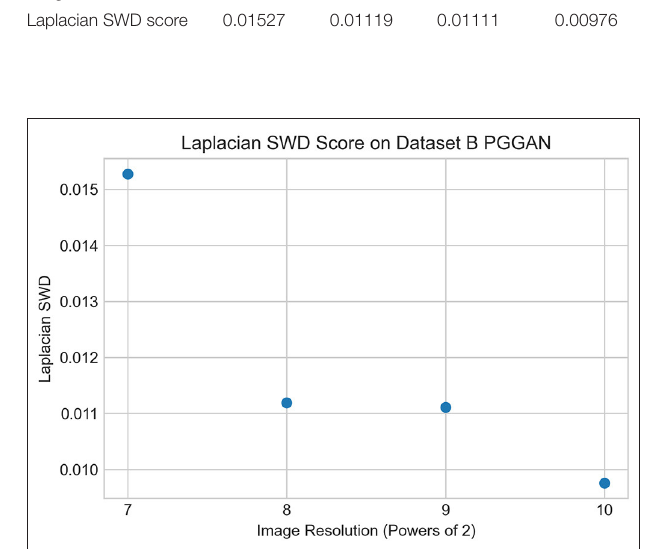
FIGURE 9 | Laplacian SWD scores for the PGGAN trained on Dataset